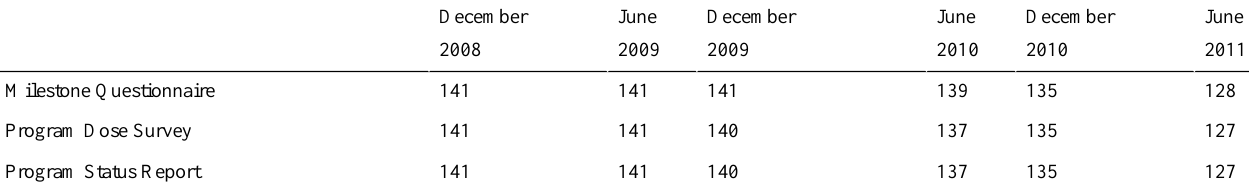
Table 2. Administration times and sample size of facility coordinator surveys for Tier 1.